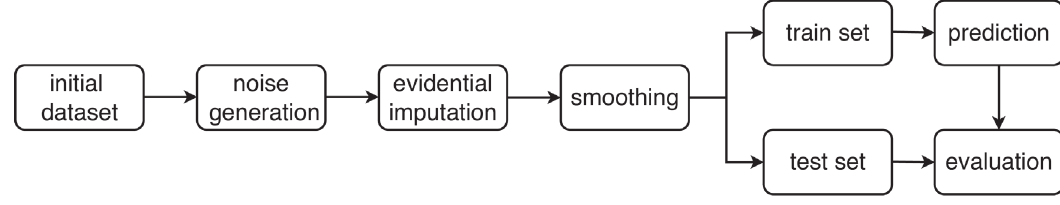
Fig 13. Experimental